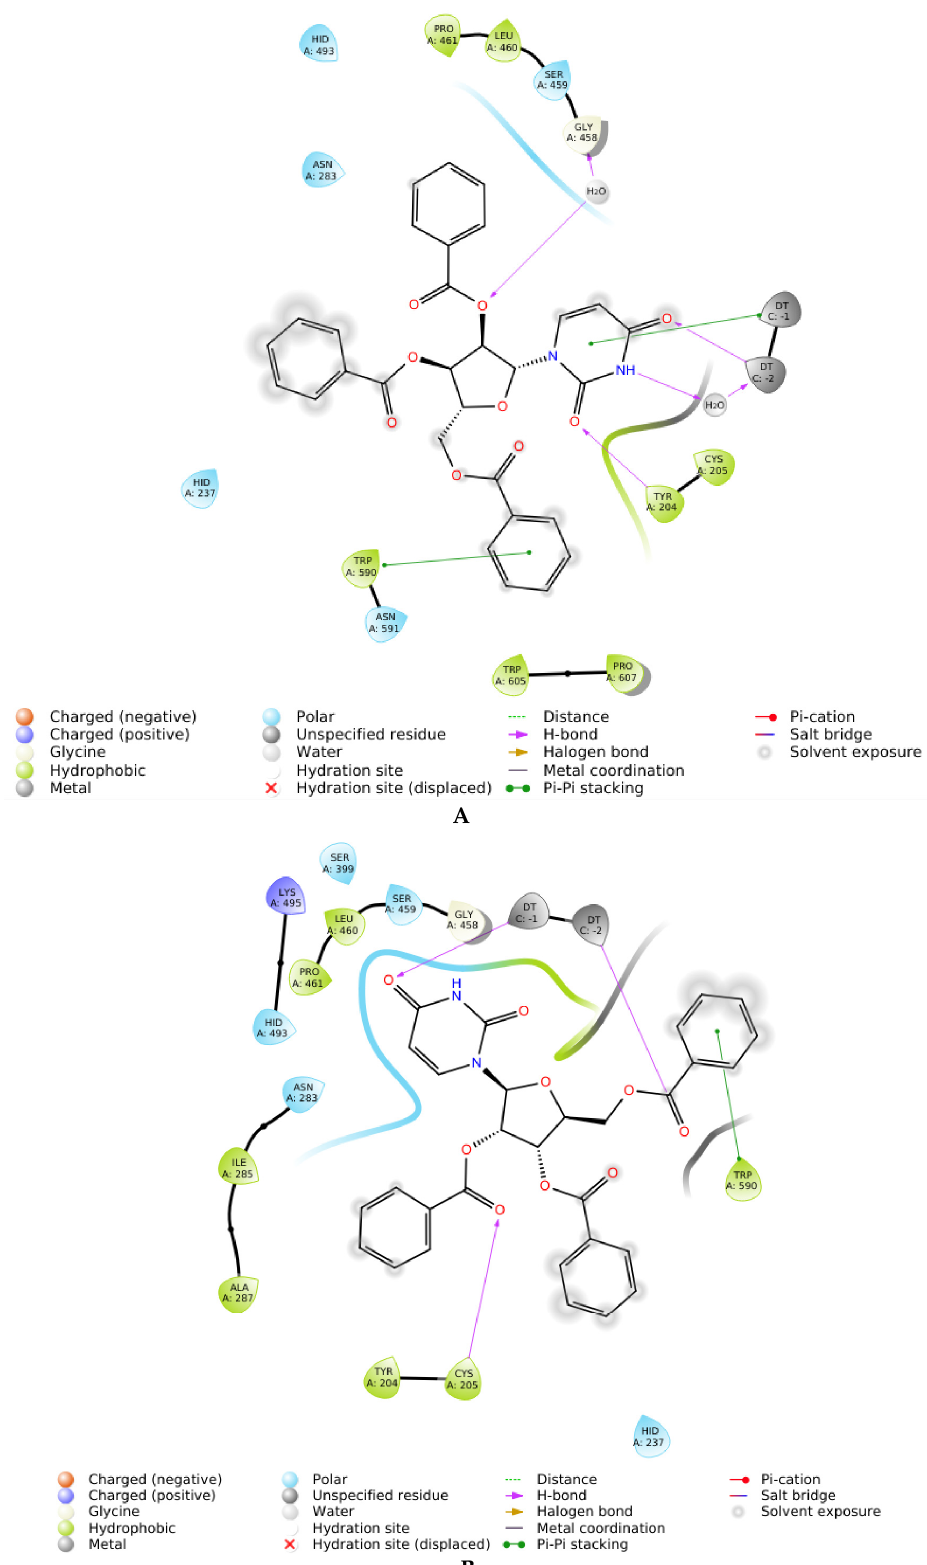
Figure 4. Interaction diagrams for D-nucleoside 3D ( A ) and L-nucleoside 3L ( B ). As was shown for the purine 5 ′ - C -methylribofuranosyl derivatives, compounds of